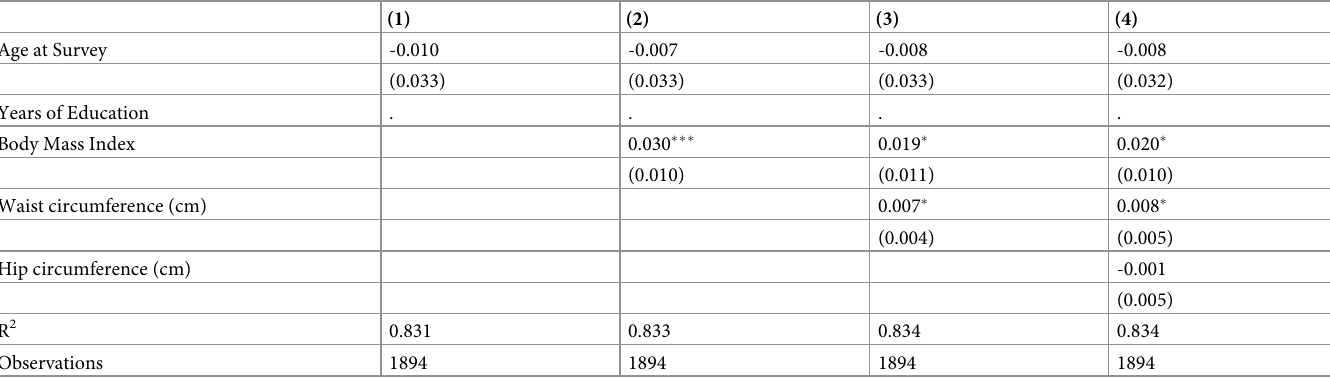
Table 3. Estimation results with individual fixed